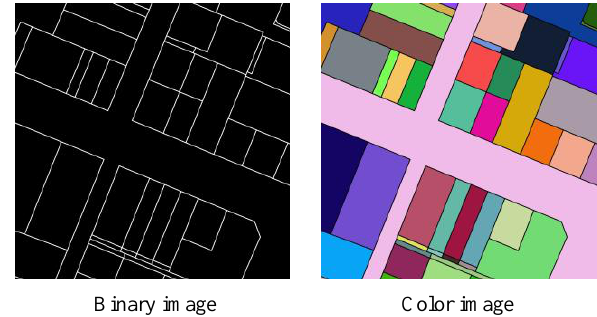
Figure 8. Two different types of input